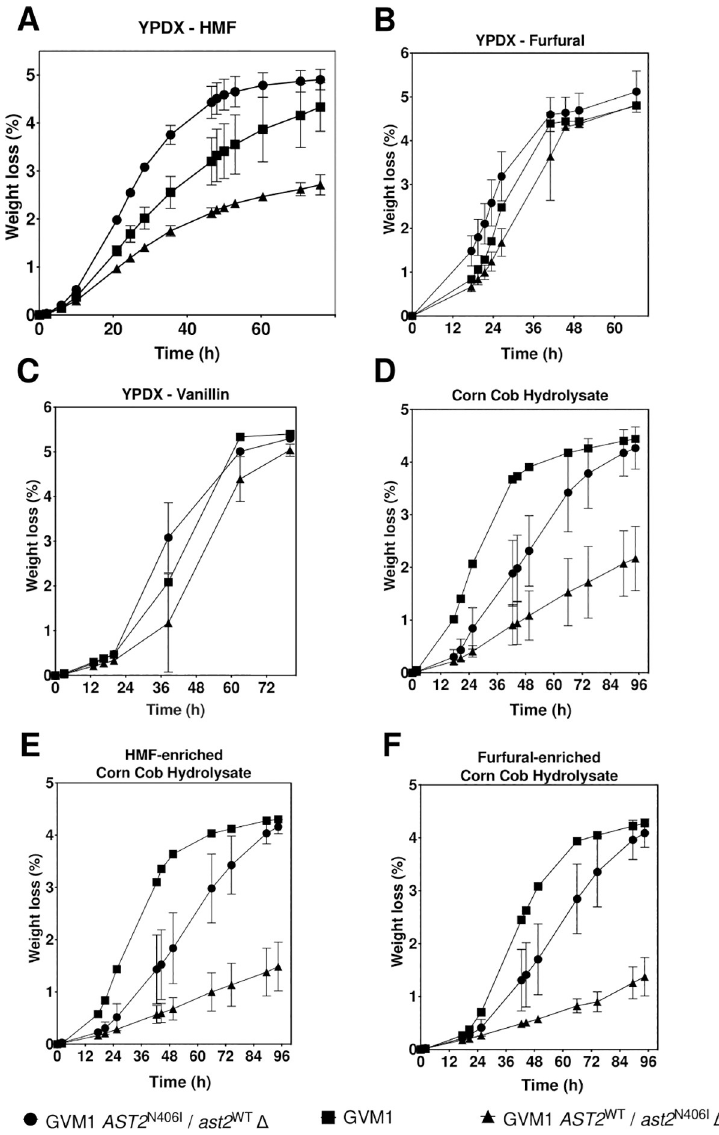
Fig 3. Fermentation performance of the two hemizygous strains of WG transformant GVM1 containing either the mutant AST2 N406I allele or the wild-type AST2 allele. Small-scale fermentations (10 mL) were performed at pH 5.2, 35˚C, 350 rpm and initial OD 5.0, in YPDX medium enriched with 12.0 g/L HMF (A), 4.0 g/L furfural (B), or 4.5 g/L vanillin (C), and in corn cob hydrolysate with no addition (D), or enriched with 1.0 g/L HMF (E) or 1.0 g/L furfural (F). Mean values with standard deviation are shown for four independent transformants of strain GVM1, or four technical replicates for strain GVM1. Representative result of two biological replicates is